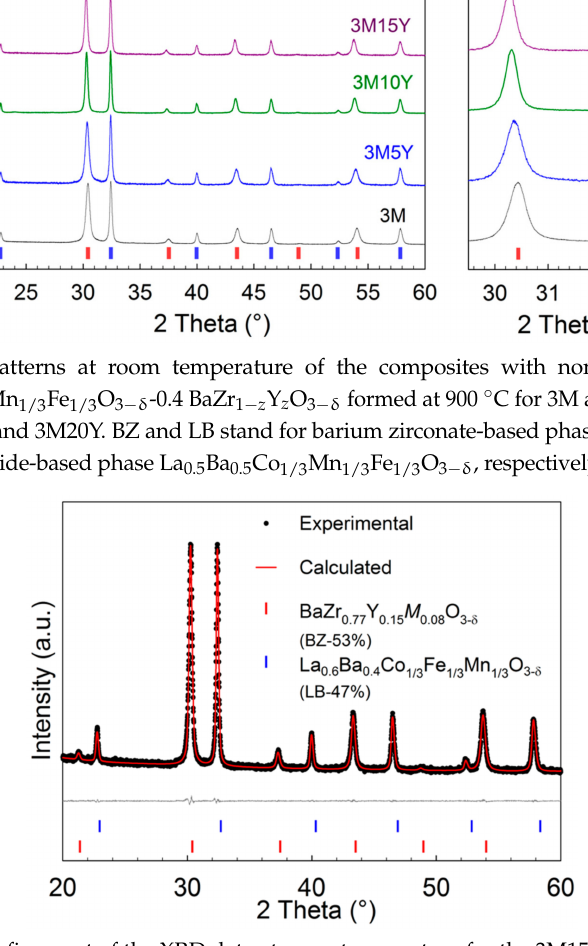
Figure 4. Rietveld refinement of the XRD data at room temperature for the 3M15Y composite using the cubic Pm − 3 m space group for both phases.